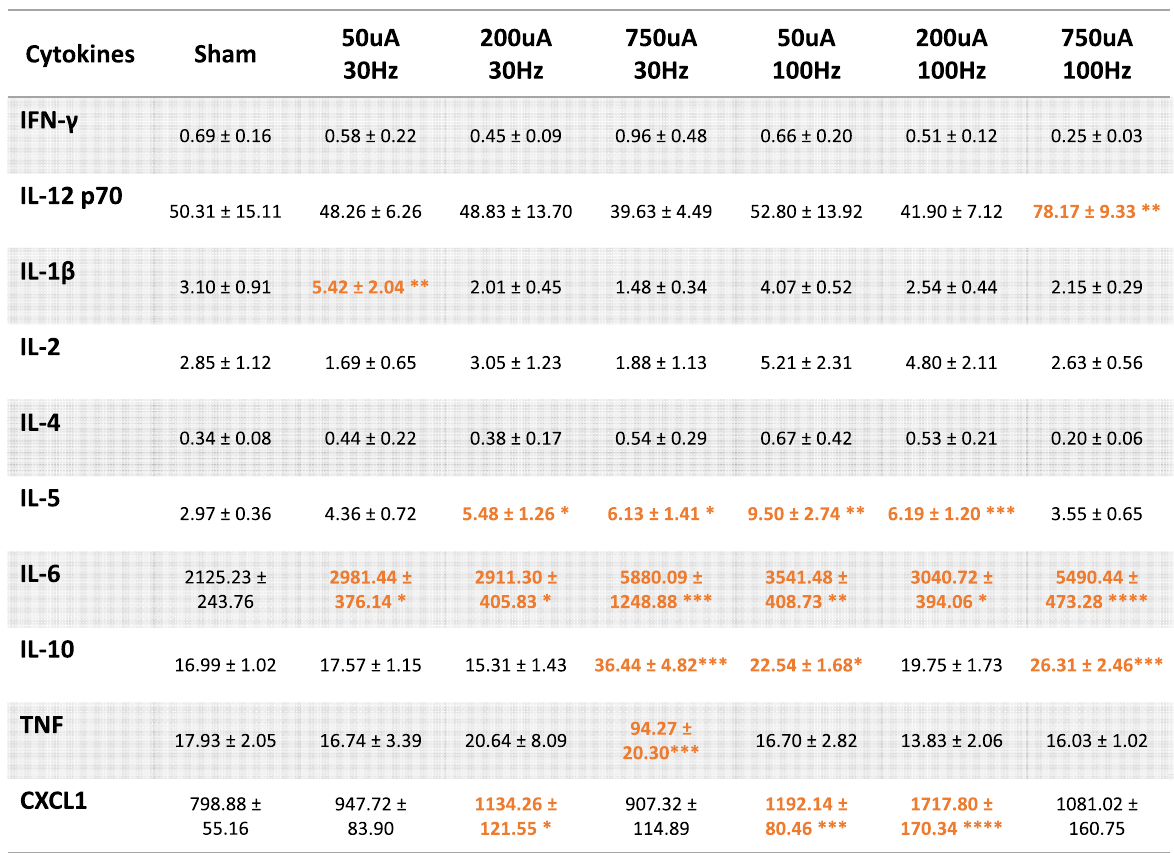
Table 2 Cytokines (mean ± SEM) at 250 μ s